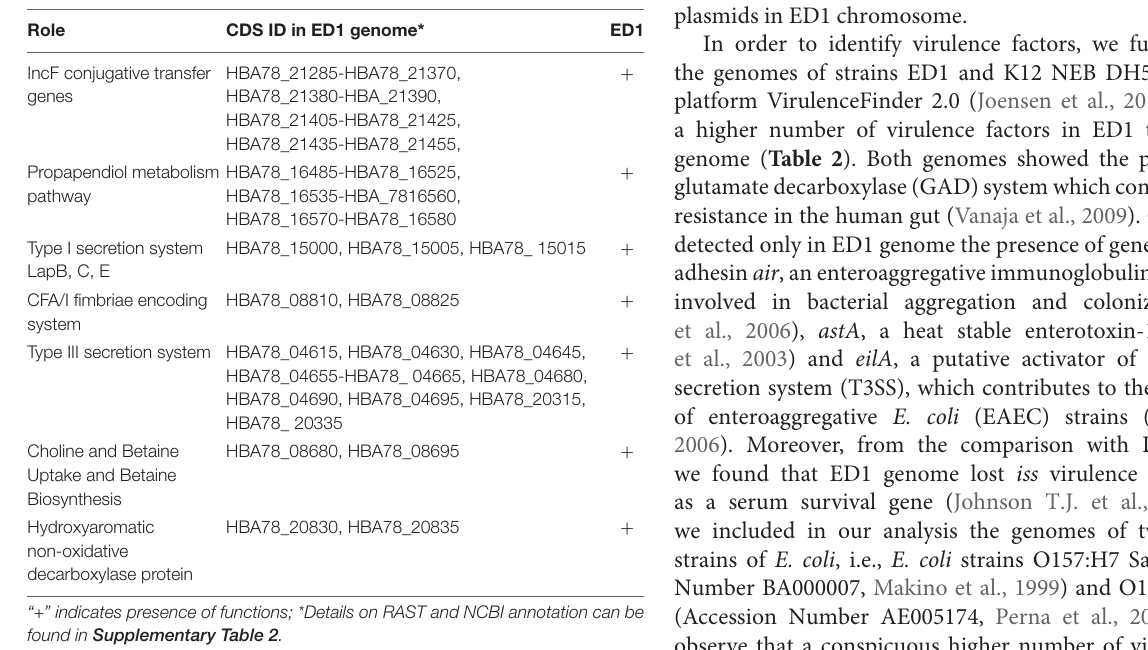
TABLE 1 | Main subsystems revealed in the genome of E. coli strain ED1.